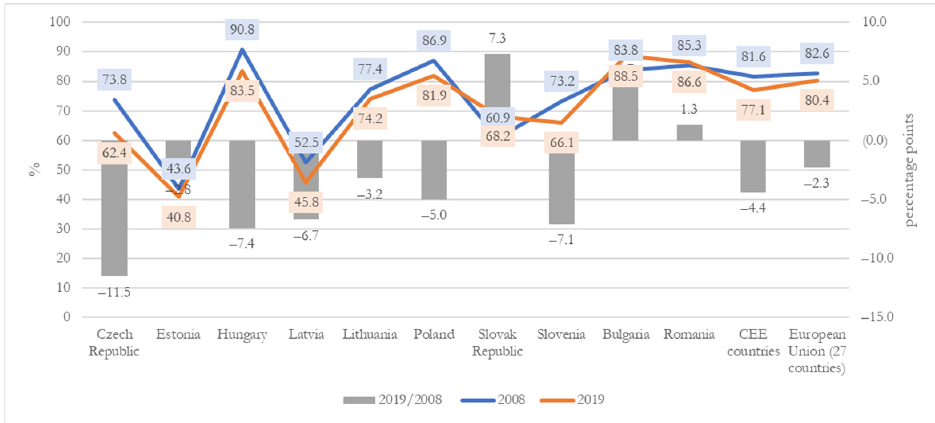
Figure 2. The share of direct material input of biomass for food and feed in direct material input of biomass (%) (based on OECD.Stat data [36], retrieved on 15 February 2022). The apparent consumption of biomass in national economies, measured by domestic material consumption, is examined in the table below (Table 8). The consumption, which takes into consideration the production extracted plus imports and minus exports, reveals almost the same pattern as in the investigation above. Poland and Romania were, in 2019, in the first places in the total of biomass consumed in CEE countries; while exploring the dynamics during the 2008–2019 period, we noticed a much slower growth and even a tendency of consumption reduction in some of the countries. Table 8. Domestic material consumption of biomass and biomass for food and feed. Total Biomass Biomass for Food and Feed Countries (Tons, Millions) (Tons, Millions)